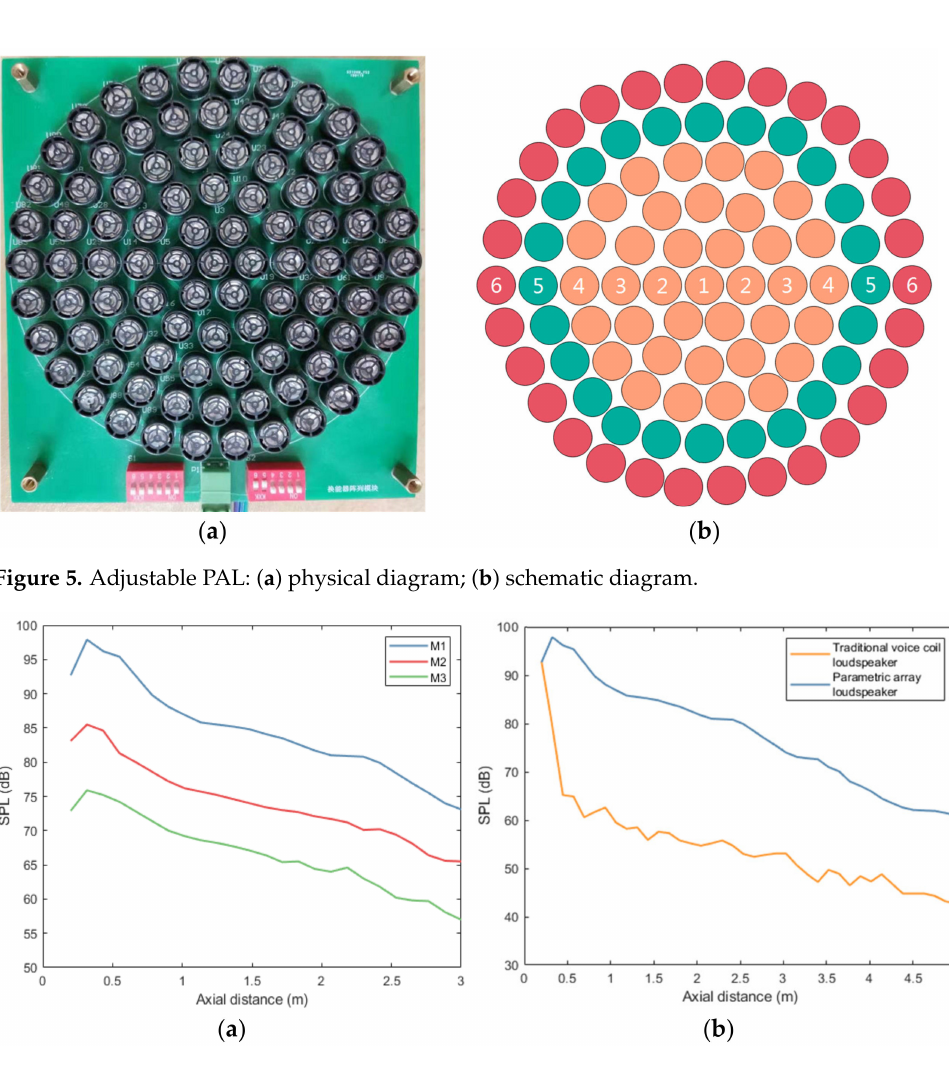
Figure 6. Axial sound pressure variation of traditional VCL and PAL: ( a ) axial sound pressure distribution of PAL in three modes; ( b ) axial sound pressure distribution of traditional VCL and